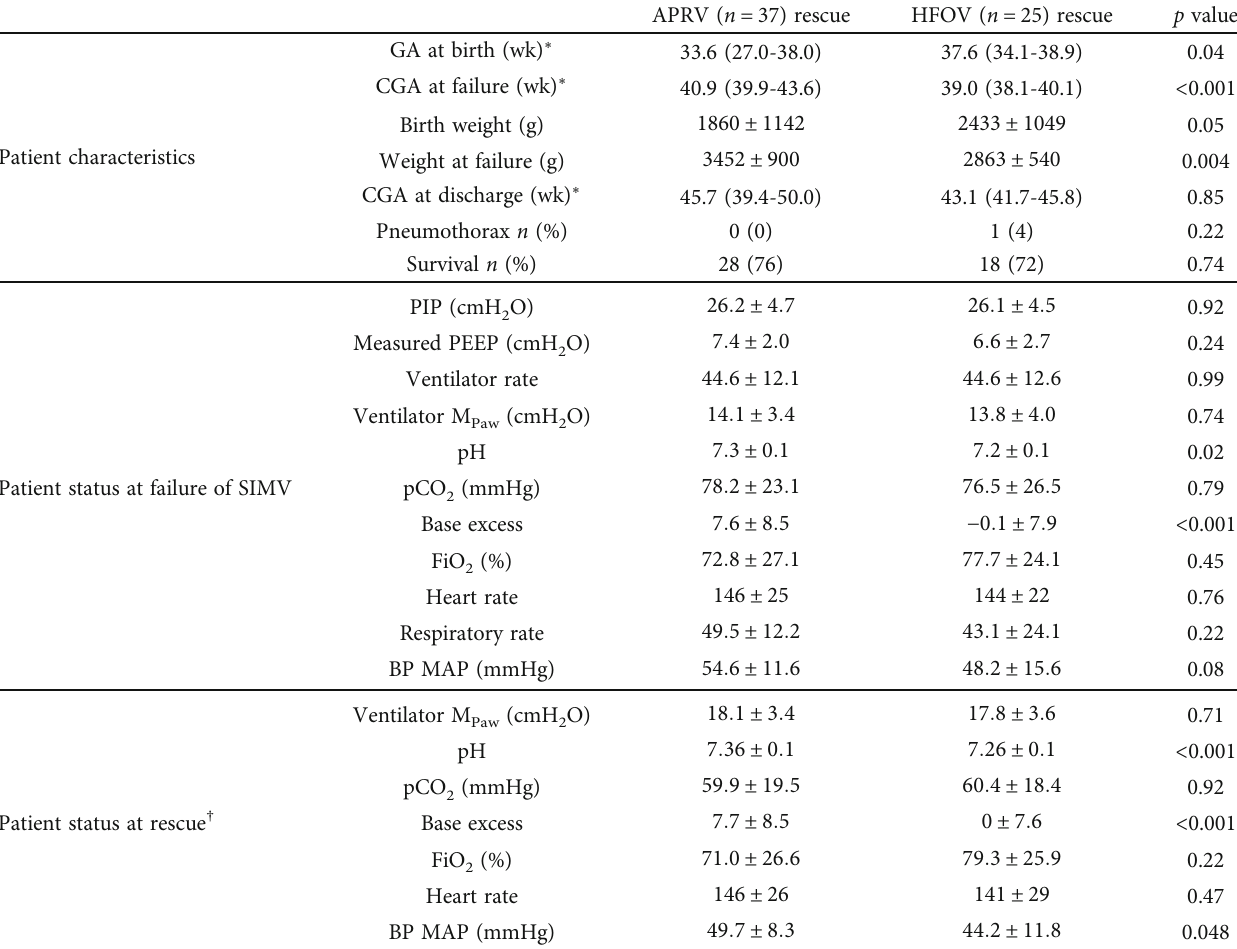
Table 3: Infants grouped by corrected gestational age (CGA) at failure ( > 37